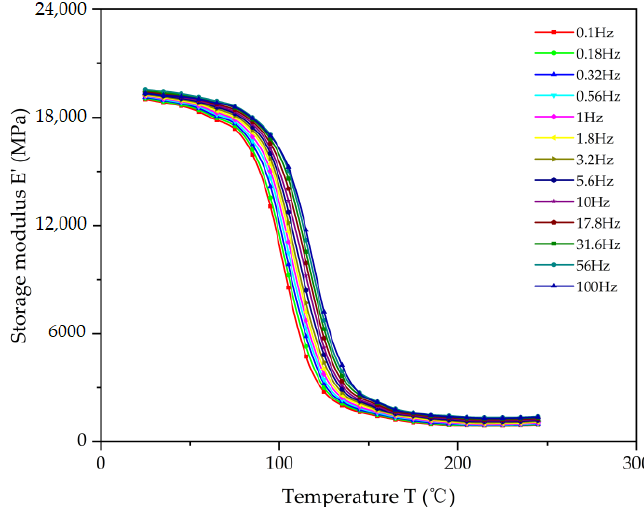
Figure 4. Storage modulus vs. temperature at different frequencies.